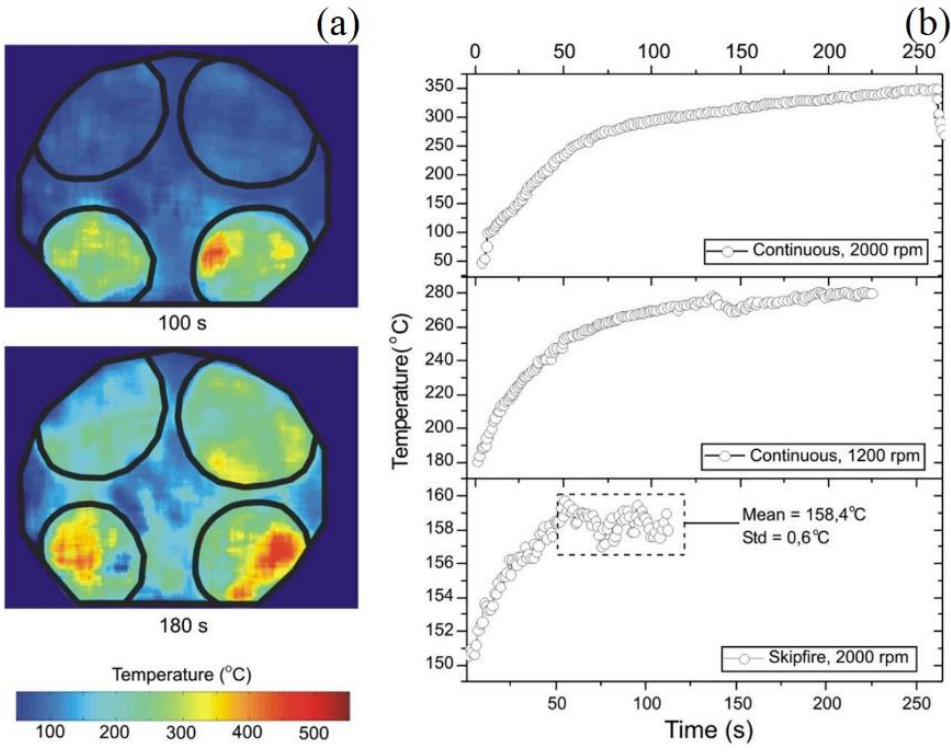
Figure 26. ( a ) Two-dimensional temperature field of exhaust and intake valves; ( b ) single-point temperature of exhaust valve temperatures under different running conditions [138]. Reprinted with permission from [138]. SAE International, 2004.